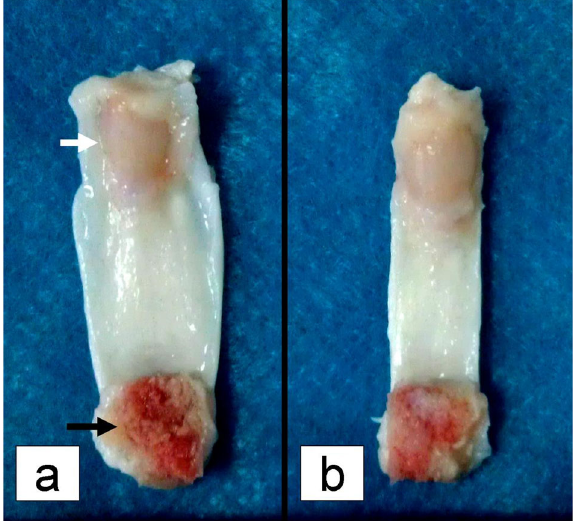
Fig. 2 Patellar tendon (PT) aponeurosis preparation prior to decel- lularization. a The patella (white arrow)-PT-tibia (black arrow) com- plex is retained with intact aponeurosis; b aponeuroses were excised on both sides of the